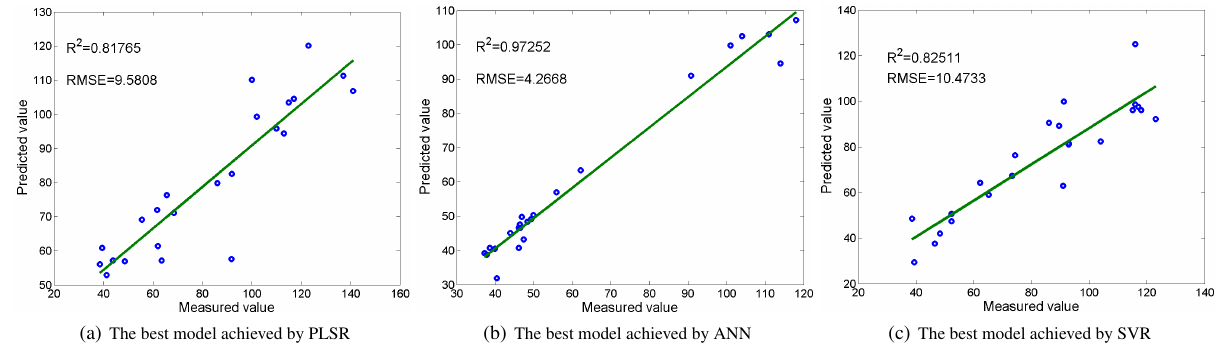
Figure 2. Best models achieved by PLSR, ANN,